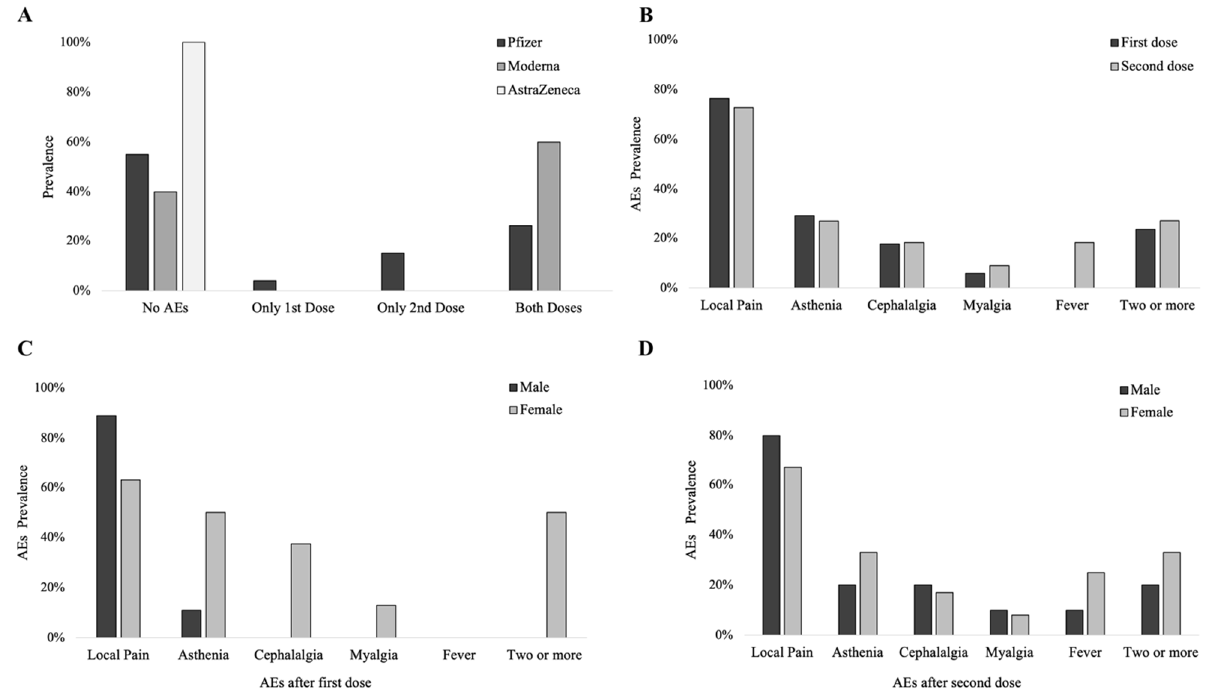
Figure 3. ( A ) Percentage of patients presenting with AEs after vaccination (vertical axis), reported according to vaccine type. ( B ) AE prevalence after first and second dose. ( C , D ) AE prevalence after first ( C ) and second dose ( D ), according to gender.